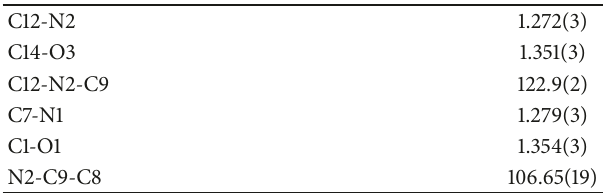
Table 2: Selected geometric parameters (˚A, ∘ ) for H 2 L 2 .